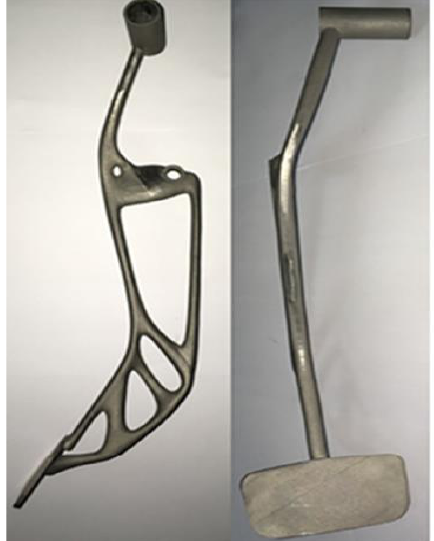
Figure 17. Metal brake pedal using BASF Ultra fuse 316L metal-polymer filament via FDM. Adapted with permission from Sargini et al. [9]. 2021, Elsevier.